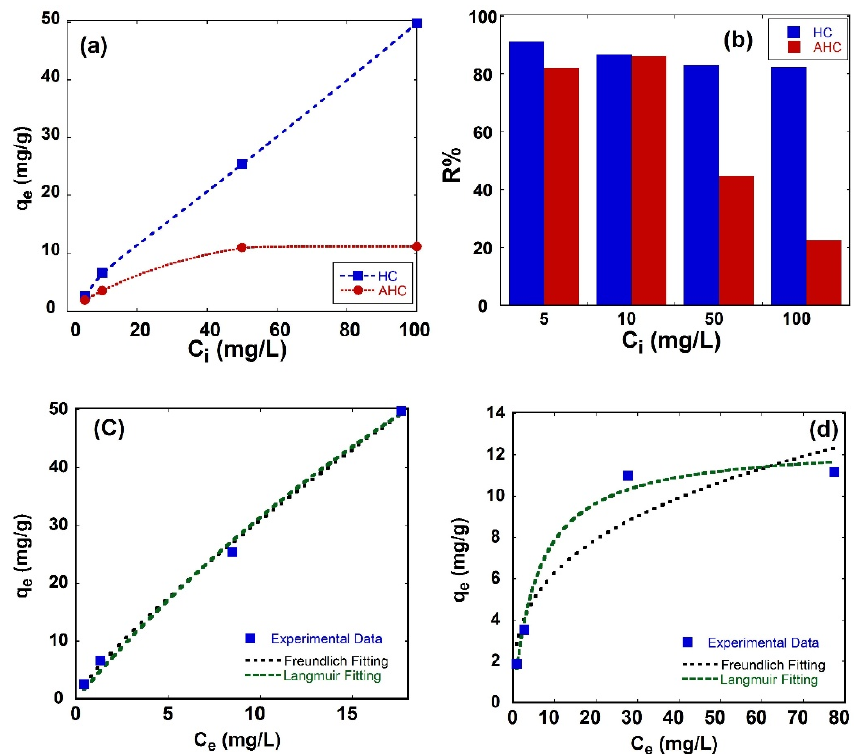
Figure 5. ( a ) The dependence of equilibrium adsorption capacity on MB dye initial concentration, ( b ) removal efficiency on MB dye initial concentration, ( c ) experimental data and fitting models of HC and ( d ) experimental data and fitting models of AHC.